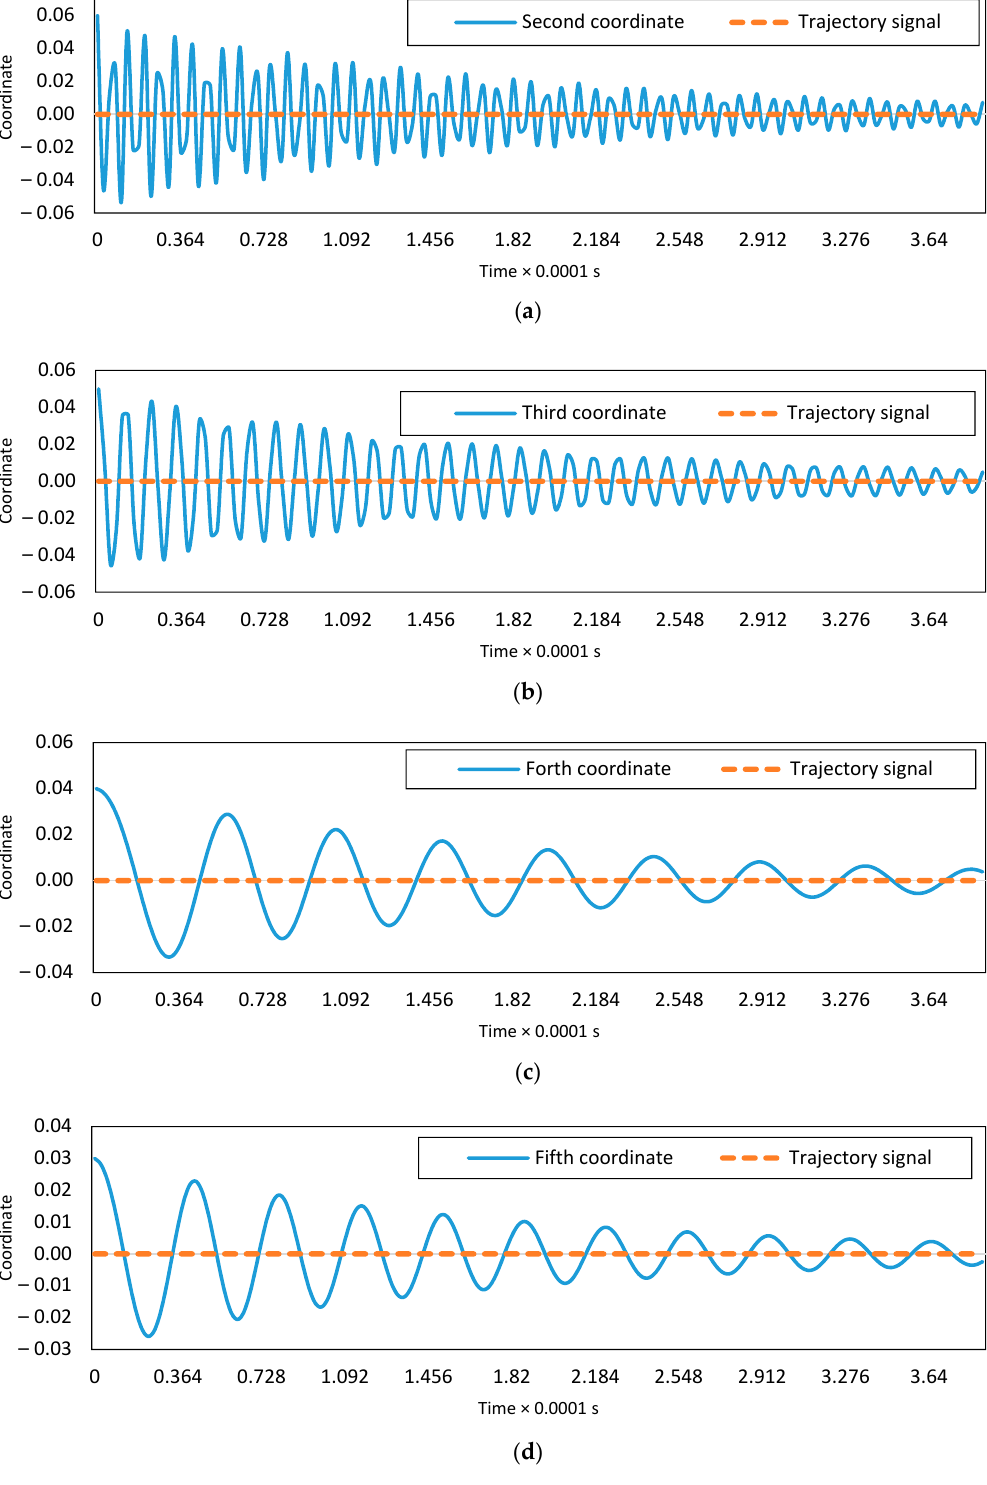
Figure 4. Desired path and controlled time response of second to fifth modes for clamped-clamped boundary condition: ( a ) the second mode, ( b ) the third mode, ( c ) the fourth mode and ( d ) the fifth mode. Figure 5 depicts the voltage values of the two electrodes. Based on the proposed control algorithm, only one of the voltage values is non-zero to decrease the control